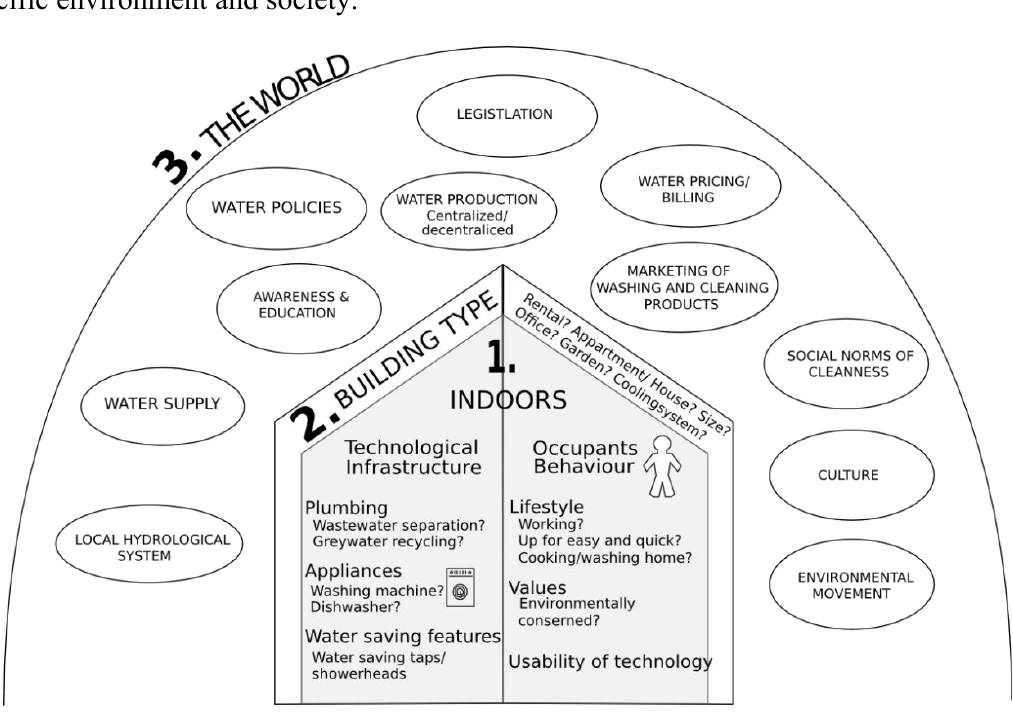
Figure 1. The three main levels influencing the water consumption of a building: (1) Indoors are situated the core elements of the domestic water system, water related technologies and activities inside the building; (2) The building type defines the frame, the building itself as well as its equipment and use; (3) The World includes the context of water use. These are all factors affecting the water technologies and water use behavior in a specific environment and